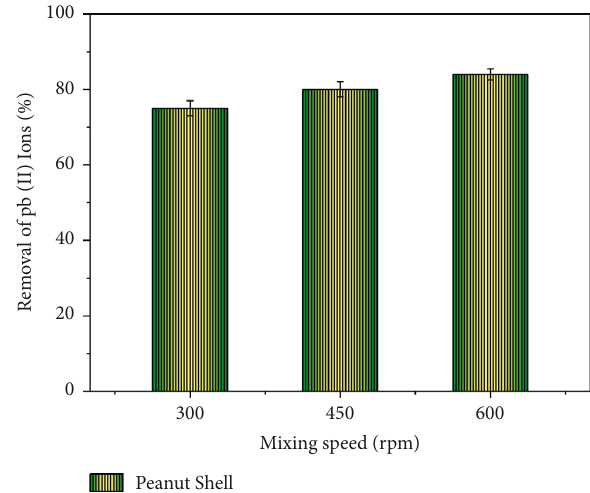
Figure 7: Influence of mixing speed on